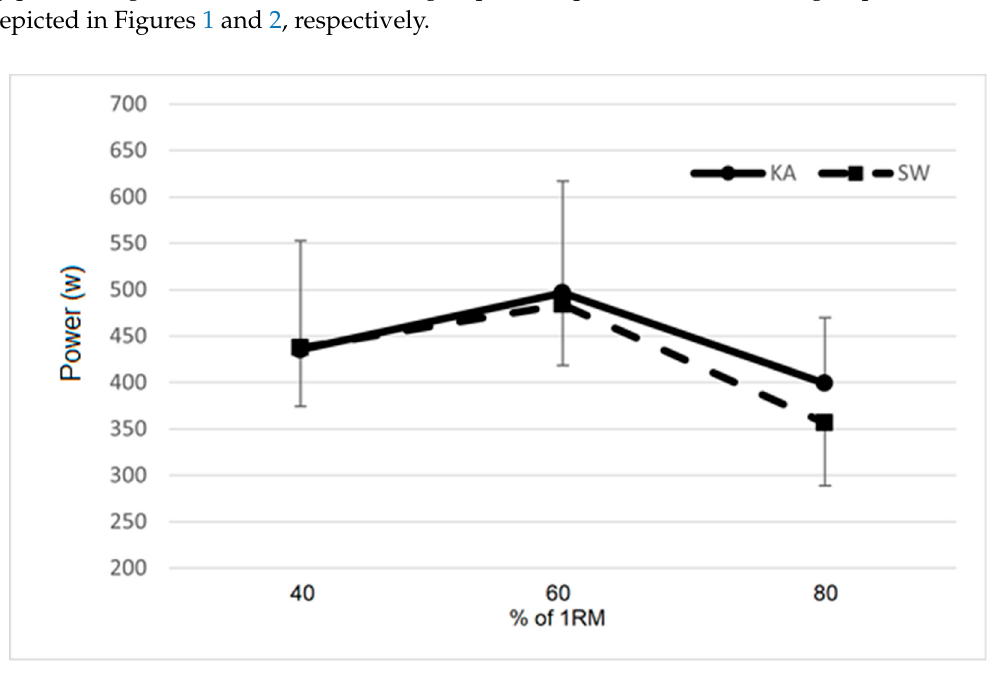
Table 1. Performance at maximum strength and power assessments in SW and KA. 1RM = 1 repetition maximum; AUC = area under the load-power curve; P ratio = power ratio. KA = kayak group; SW = swimming group.